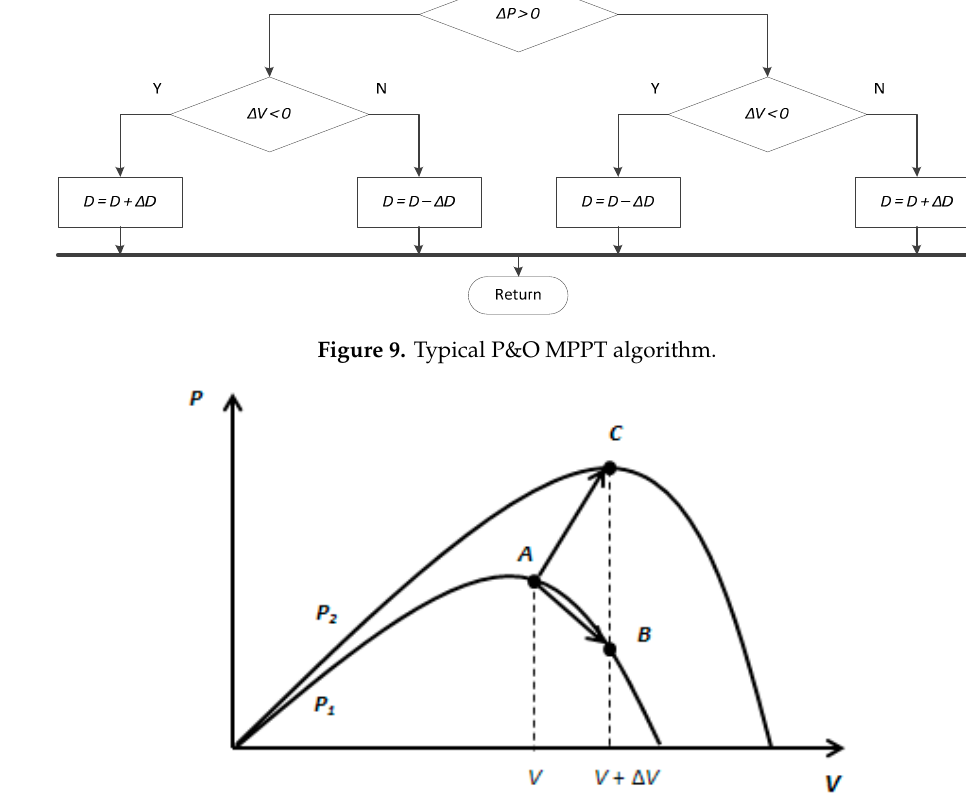
Figure 10. Divergences of HC and P&O from MPP.